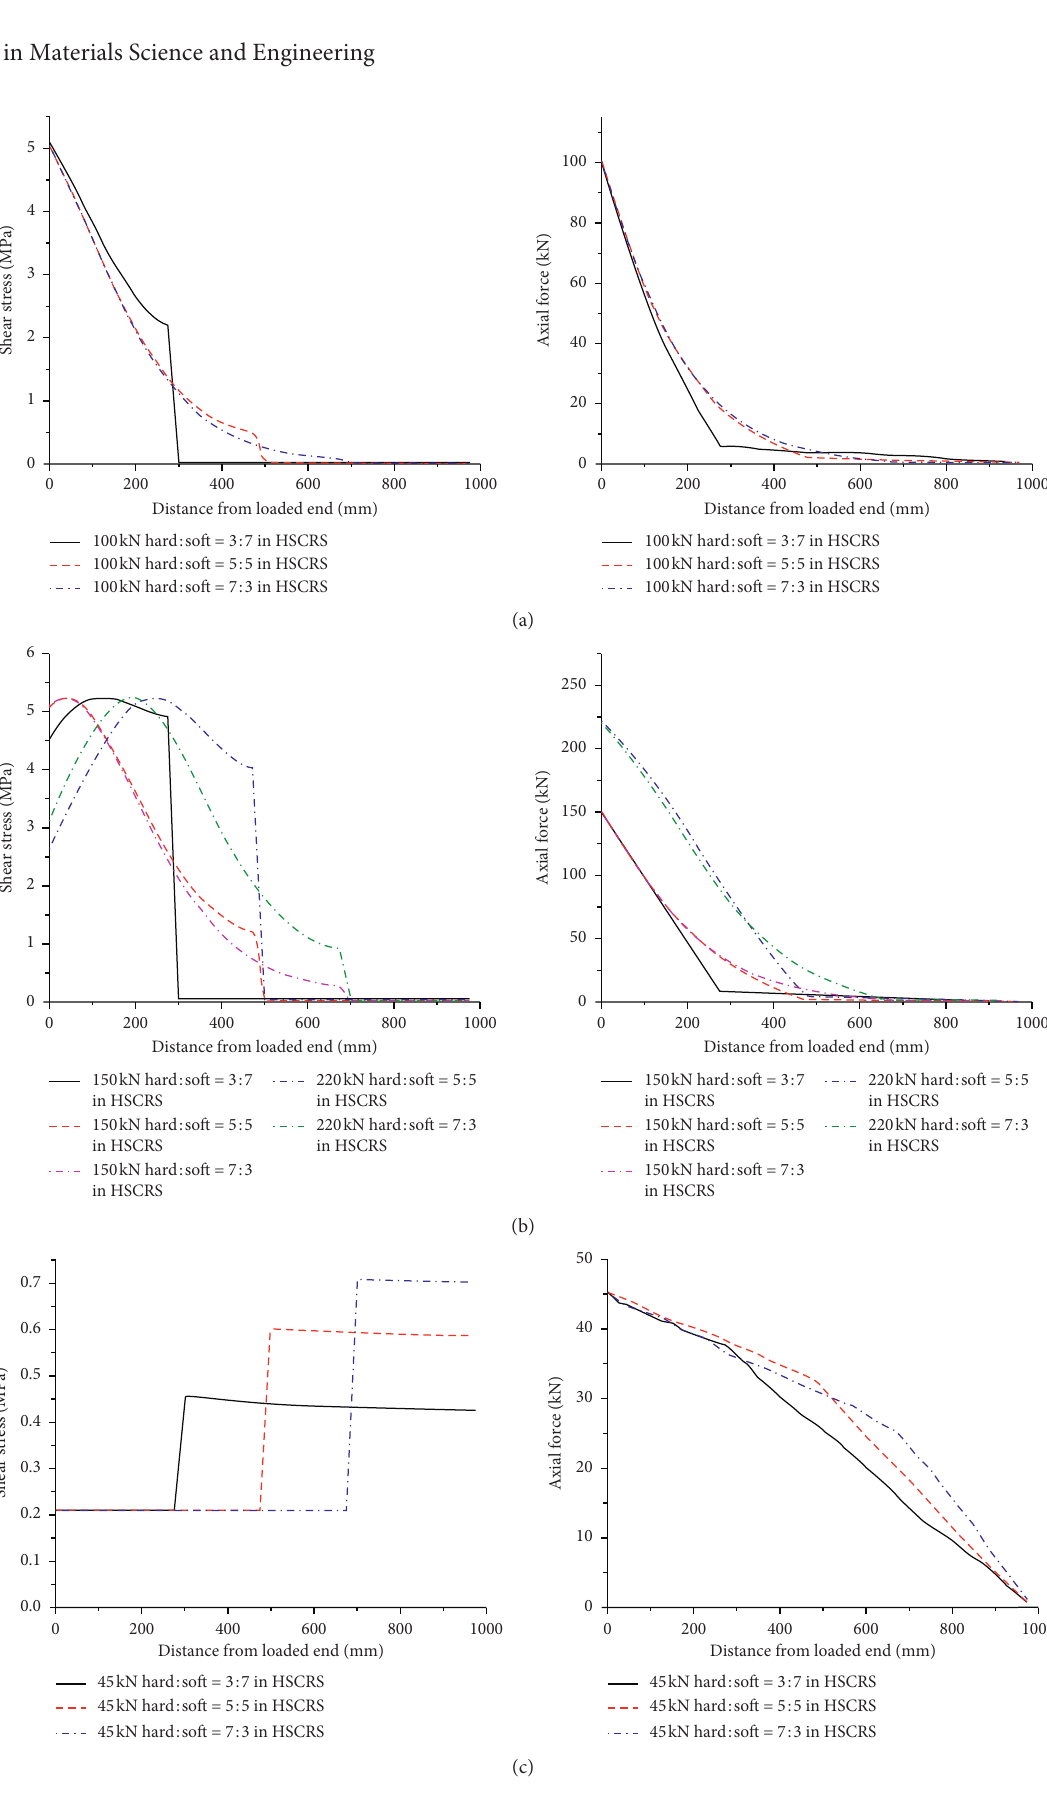
Figure 17: Shear stress (left) and axial force (right) distribution curves of soft to hard thickness ratios (7: 3, 5 :5, and 3: 7) in HSCRS. (a) Linear stage. (b) Nonlinear stage. (c) Softening and debonding